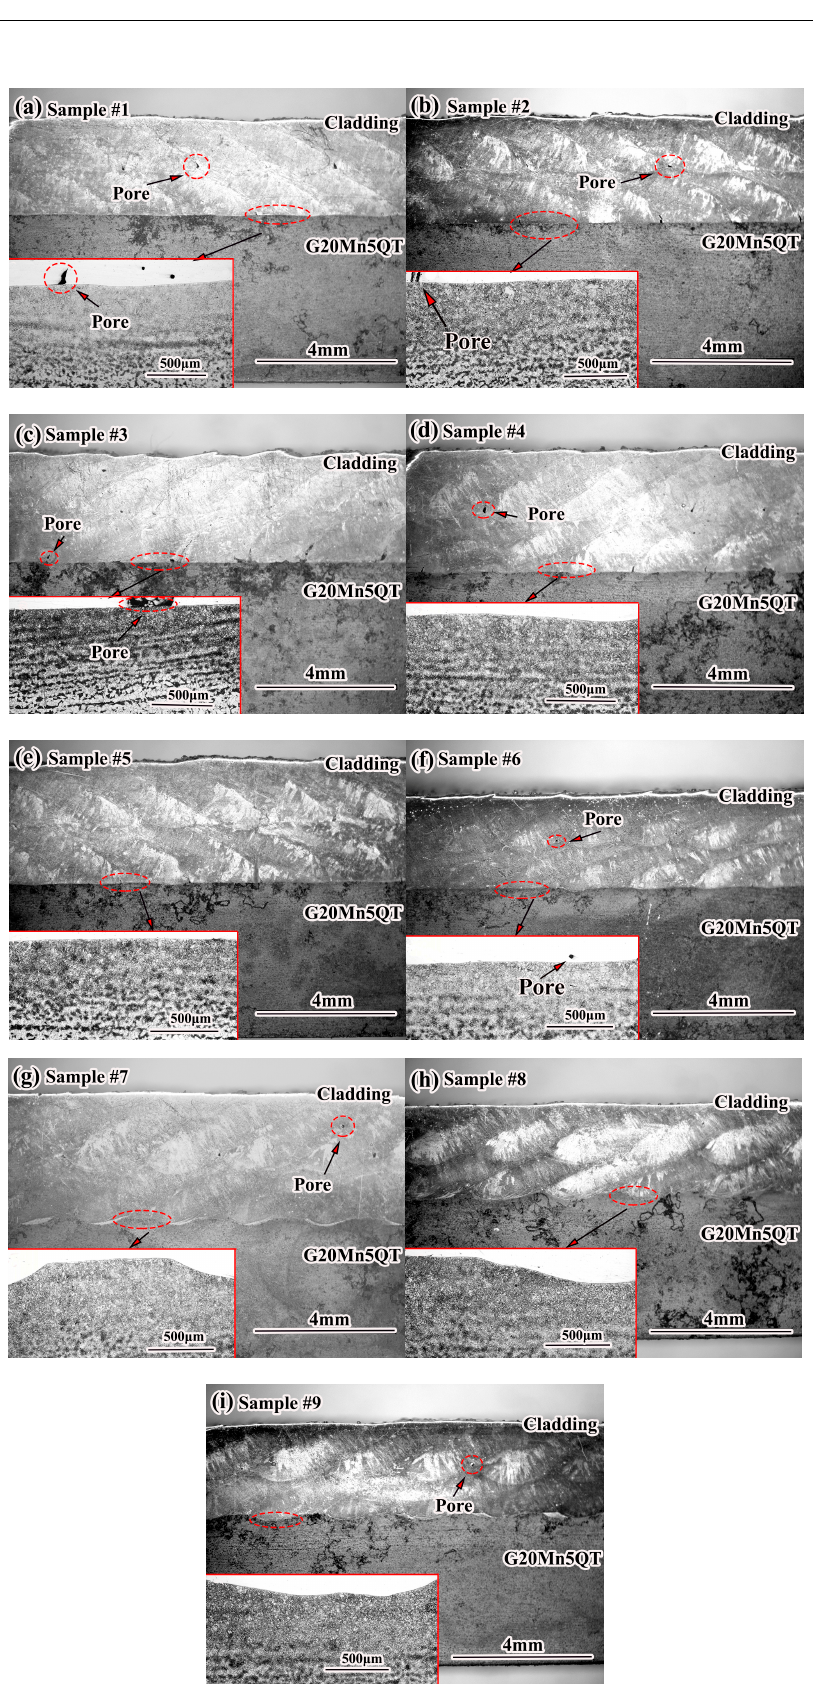
Figure 4. Cross-sectional morphology of the specimens under the optical microscope: ( a ) No. 1; ( b ) No. 2; ( c ) No. 3; ( d ) No. 4; ( e ) No. 5; ( f ) No. 6; ( g ) No. 7; ( h ) No. 8; ( i ) No.